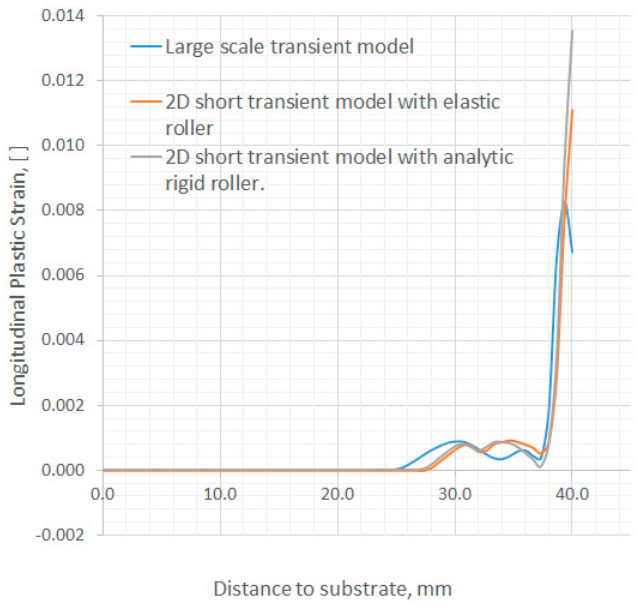
Figure 13. Longitudinal PS distributions on inspection planes.